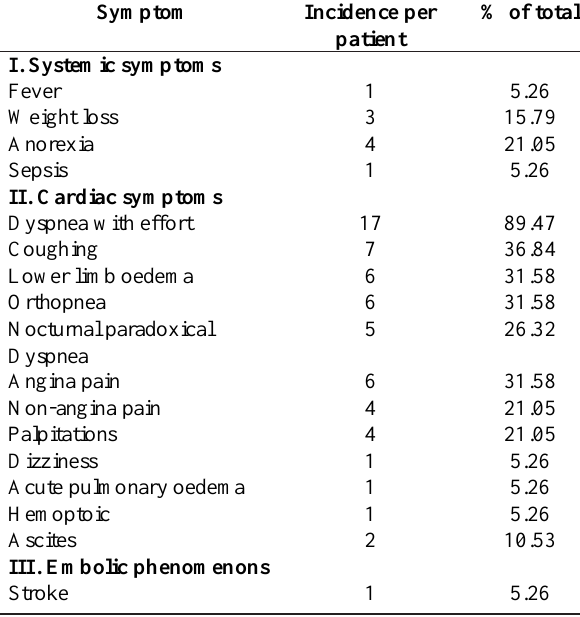
Table 1. Principal clinical manifestations presented by patients with cardiac